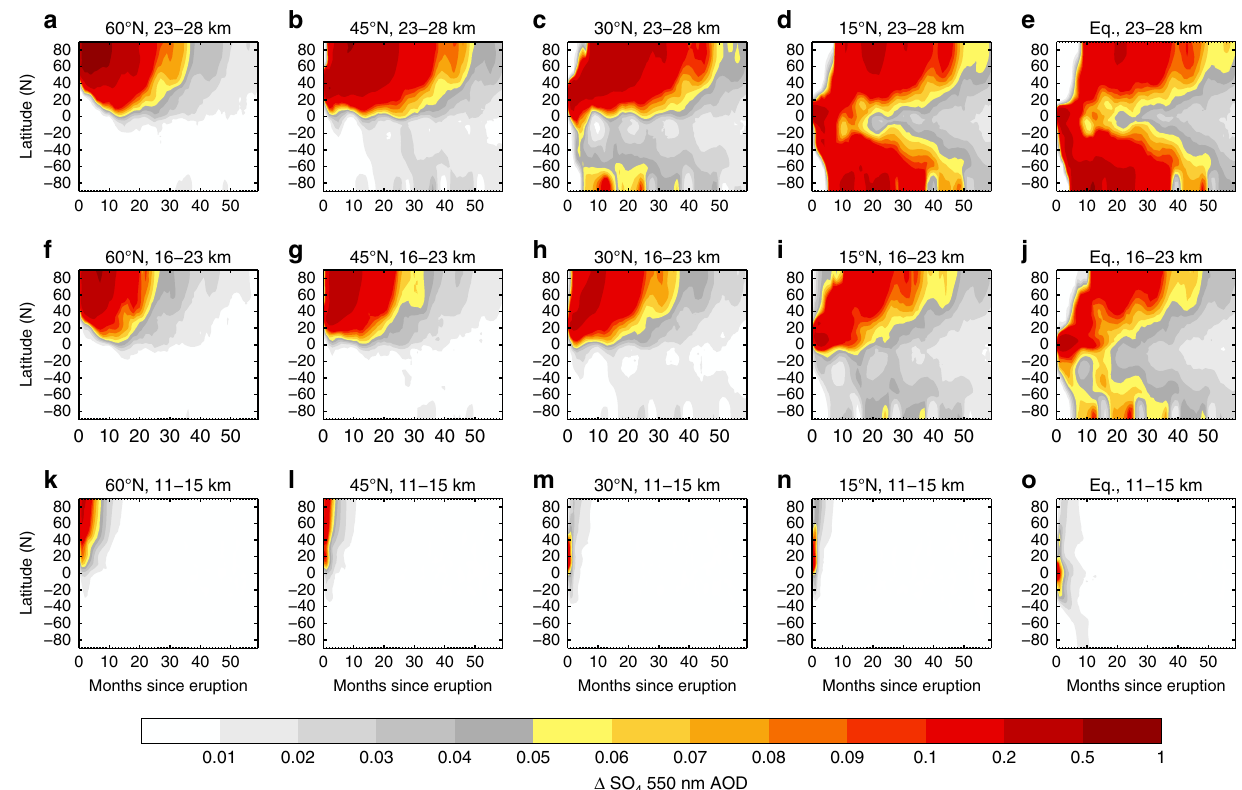
Fig. 1 Investigating the sensitivity of aerosol dispersion to the altitude and latitude of a volcanic eruption. Five-year evolution of the anomaly in sulphate (SO 4 ) aerosol optical depth (AOD) for injections of sulphur dioxide into the Northern Hemisphere. Latitudes progress from 60 o N in the left column ( a , f , k ) to the Equator in the right column ( e , j , o ) and injection altitudes from 23 to 28 km in the top row ( a – e ) to 11 – 15 km in the bottom row ( k – o ). Simulations are with a ‘ high-top ’ version of the HadGEM2 model with stratospheric layers up to 80 km using the CLASSIC aerosol scheme